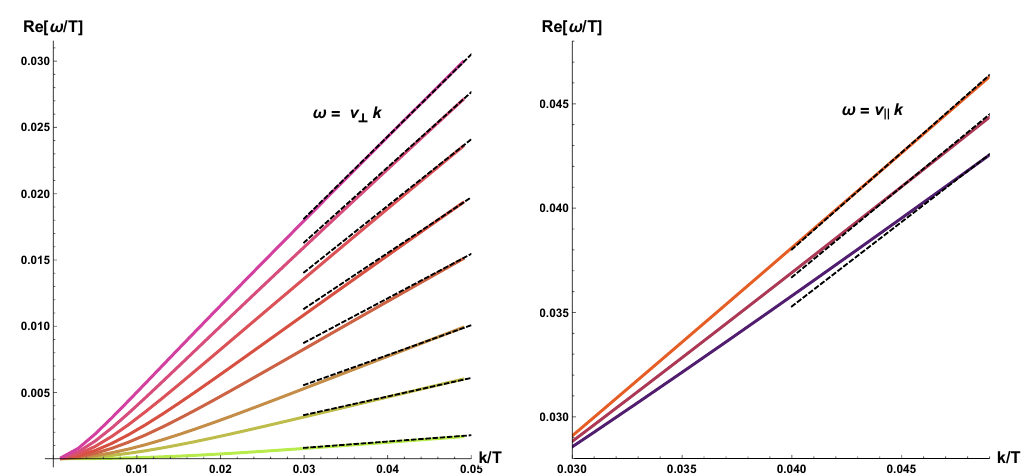
Figure 14 . The dispersion relations of the magnetophonons (left) and magnetoplasmons (right) at large momentum. The black dashed lines indicate the decoupled phonon dispersion relations Re[ ! ] = v k . Eventually, going at even larger momenta both the modes will interpolate into the ? ; k relativistic dispersion relation Re[ ! ] = k imposed by the AdS 4 UV (cid:12)xed point. The data are the same of (cid:12)gure 11 and (cid:12)gure 12 where we kept (cid:12)xed (cid:22)=T = 1 and B=T 2 = 0 : 5 and moved m=T .